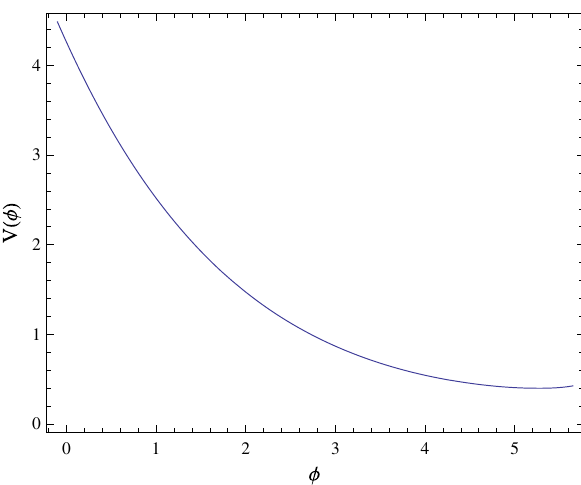
Fig. 16 Variation of V (φ) with the variation of φ for the CPL param- eterization (Model